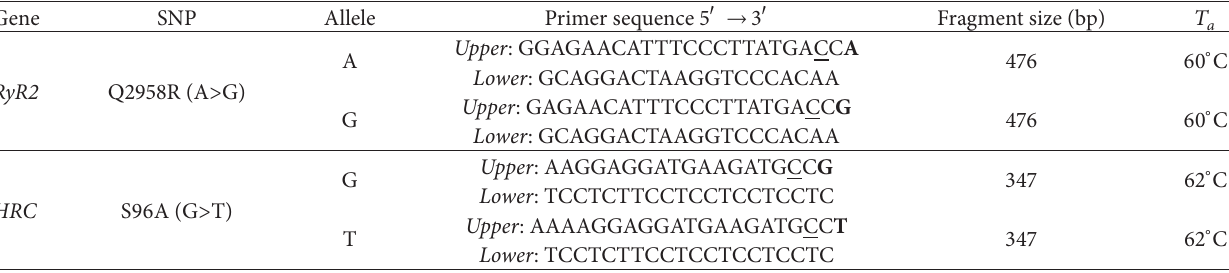
Table 1: Primers sequences, annealing temperatures, and fragment